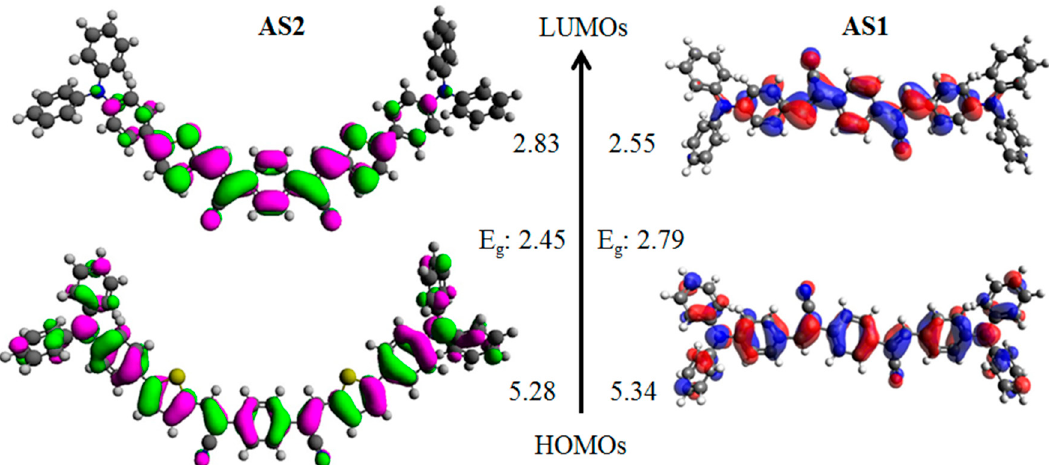
Figure 5. Orbital density distribution for the frontier molecular orbitals of AS2 and AS1 . DFT calculations were performed using the Gaussian 09 suite of programs and the B3LYP/6-311 + G(d,p)//B3LYP/6-31G(d) level of theory. Theoretical HOMO/LUMO energy levels and band-gaps ( vs . Vac scale) are also shown.